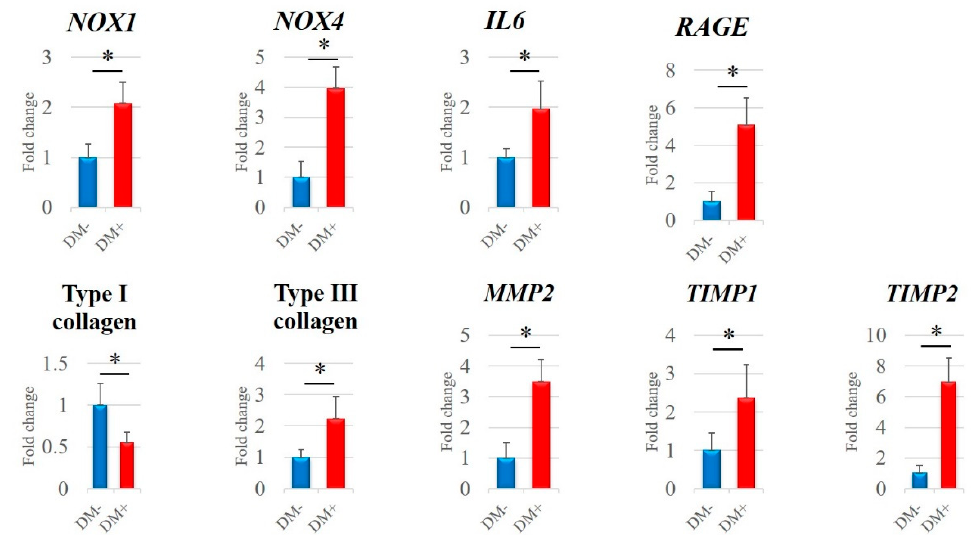
Figure 3. mRNA expression levels analyzed by quantitative reverse transcription polymerase chain reaction (qRT-PCR). NOX1 , NOX4 , IL6 , RAGE , type I collagen, type III collagen, MMP2 , TIMP1 , and TIMP2 mRNA expression levels were quantified in the diabetic group and non-diabetic controls. Data are presented as the mean ± SD. The independent t-test was performed for determining significant differences: * p < 0.05. NOX, nicotinamide adenine dinucleotide phosphate oxidase; IL, interleukin; RAGE, receptor for advanced glycation end-products; MMP, matrix metalloproteinase; TIMP, tissue inhibitor of matrix metalloproteinase.